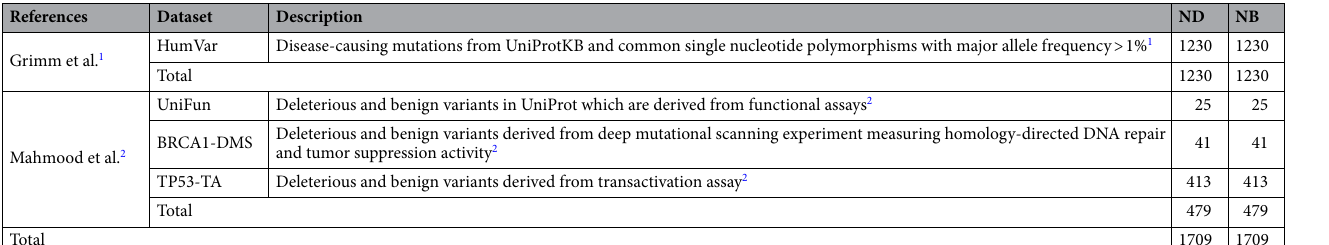
Table 1. Test datasets used and the number of deleterious and benign variants for each dataset used for evaluation. ND stands for the number of deleterious variants, and NB stands for the number of benign